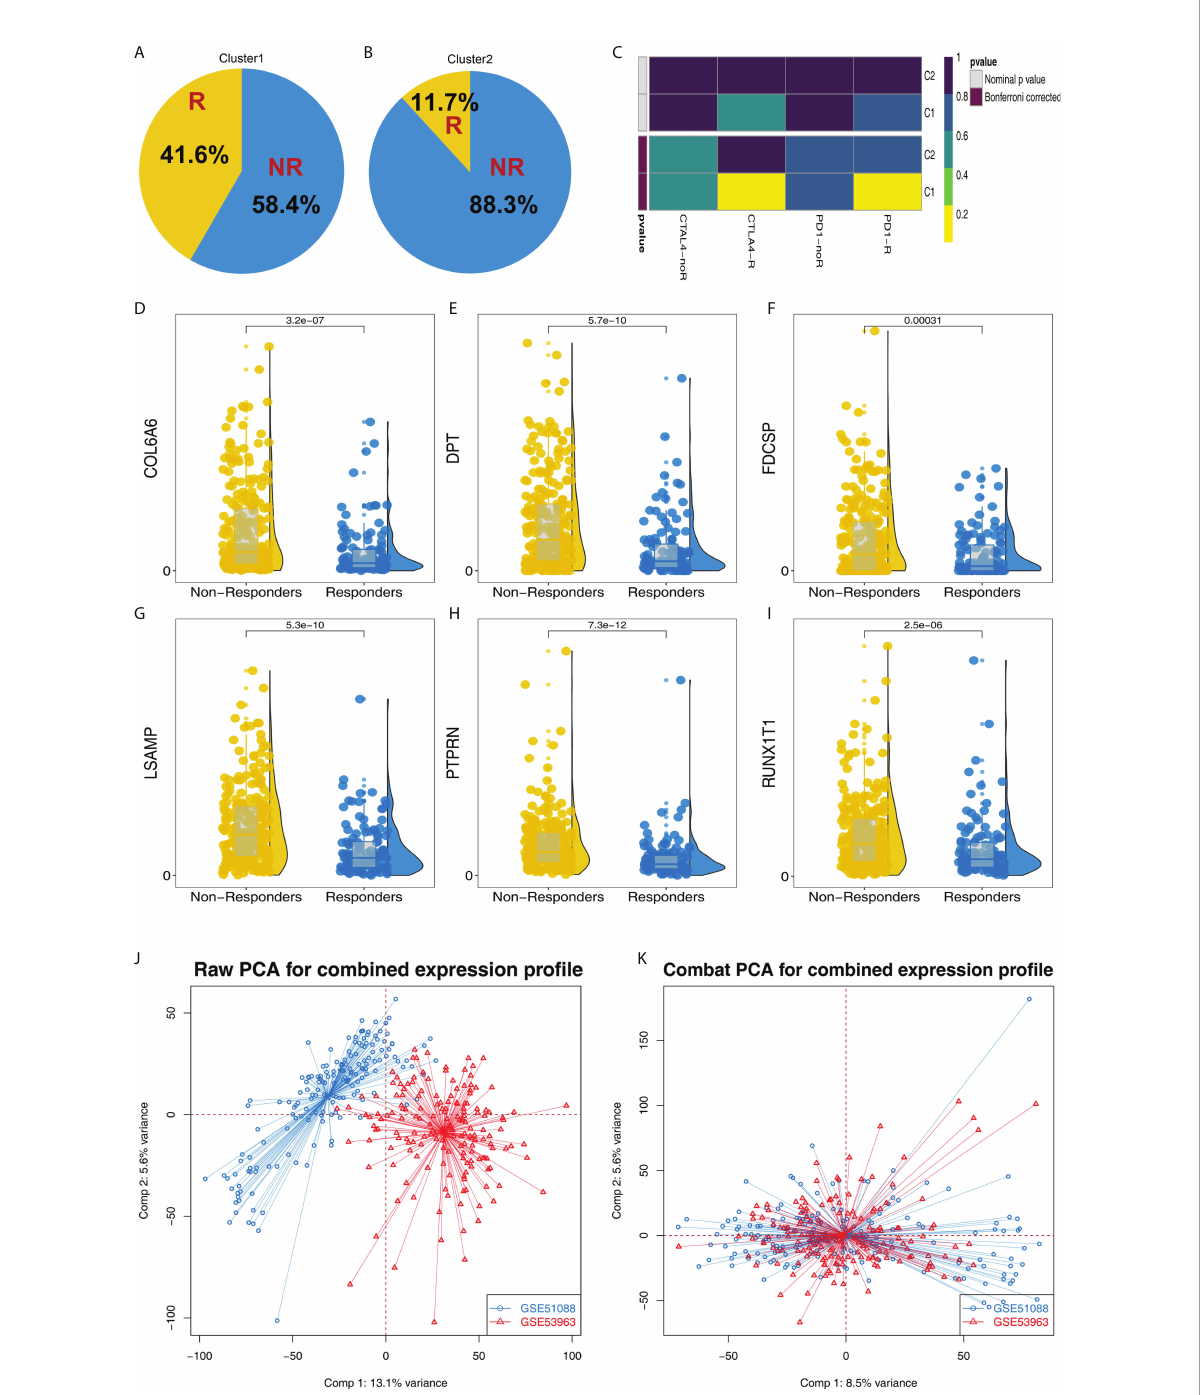
FIGURE 3 Cluster1 and Cluster2 had different immunotherapy response. (A, B) The proportion of immunotherapy responders and non-responders in Cluster1 and Cluster2 patients; (C) Submap algorithm indicated that the Cluster1 patients are sensitive to both PD-1 and CTLA4 therapy; (D – I) The expression level of DPT, RUNX1T1, PTPRN, LSAMP, FDCSP and COL6A6 in immunotherapy responders and non- responders; (J – K) Sva package was used for data combination and batch effect reduction of GSE51088 and